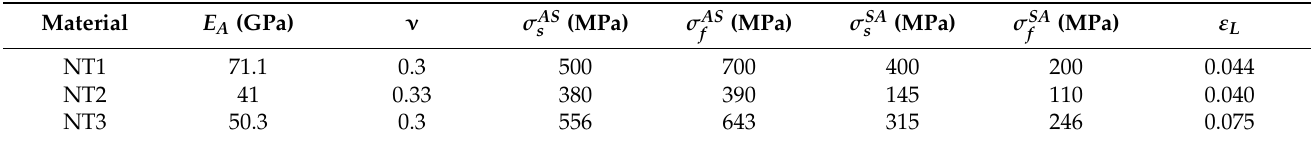
Table 1. Material data [11,95,96] used in the FEA models for determining the stress–strain